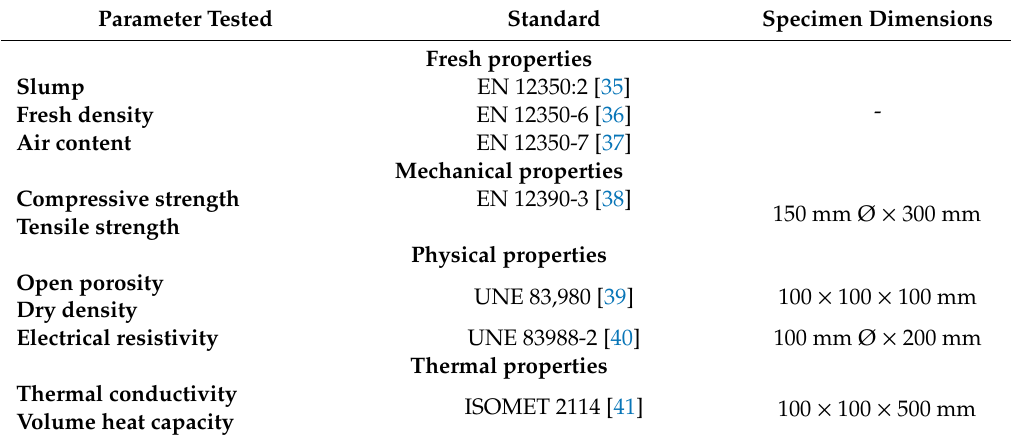
Table 5. Properties of the concrete mixes